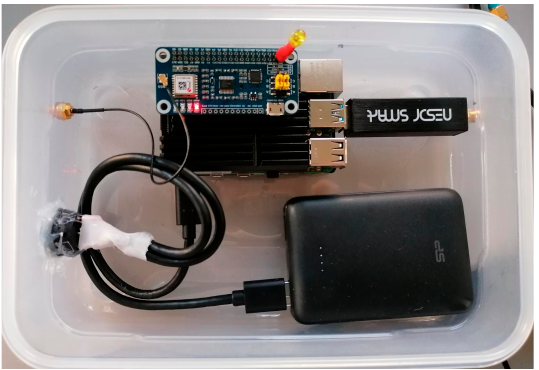
Figure 3. Top-view on the system hardware: the SBC, GNSS pHat, NeSDR, and power